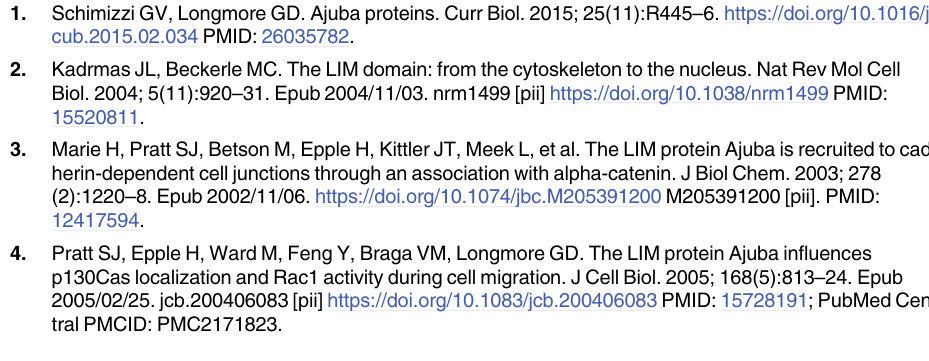
S2 Fig. Full gel